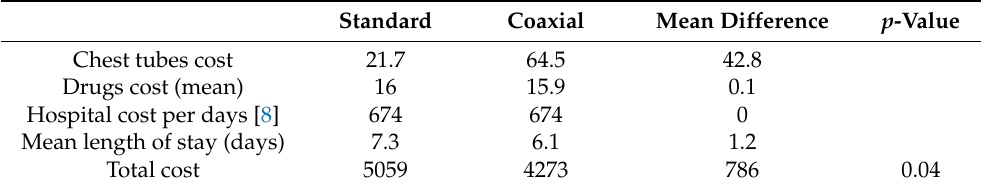
Table 3. Cost analysis. Costs are indicated in euro. Total cost = (hospital daily cost + cost of drugs) × mean length of stay + chest tubes cost (single